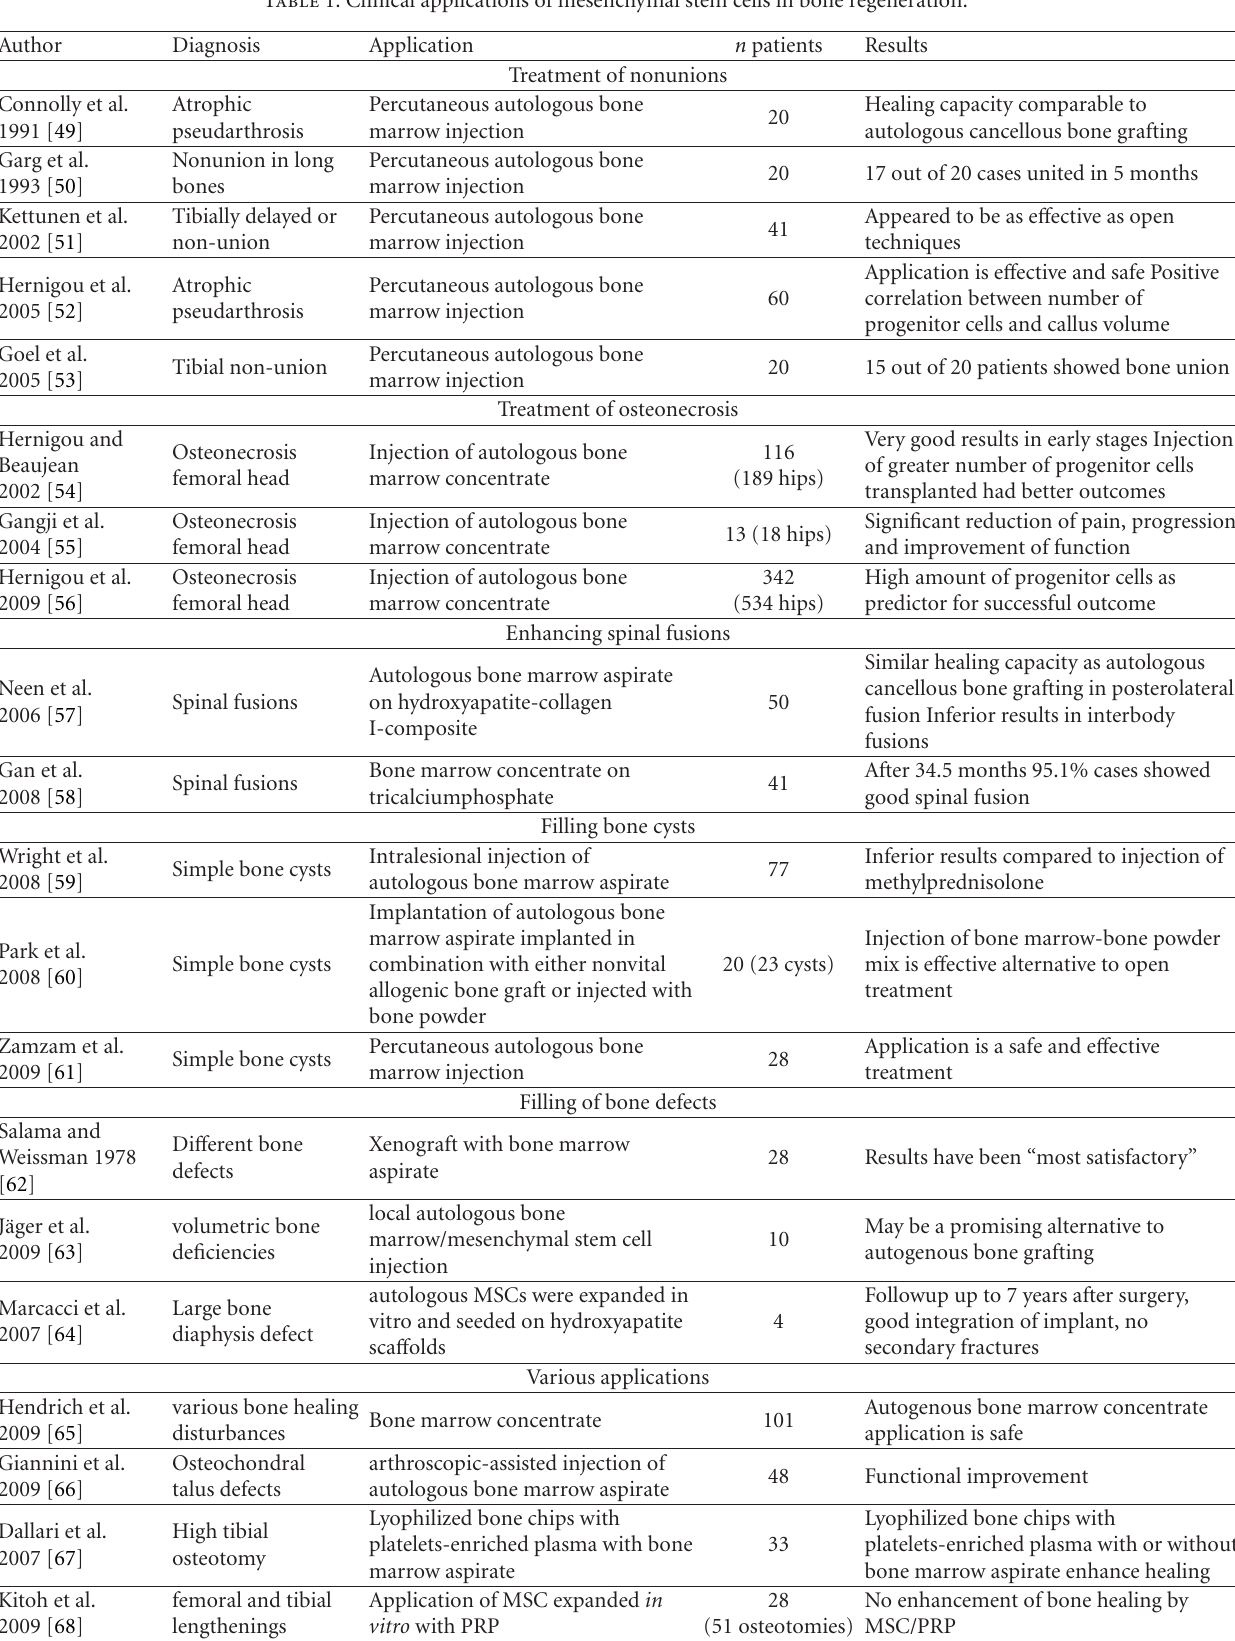
Table 1: Clinical applications of mesenchymal stem cells in bone